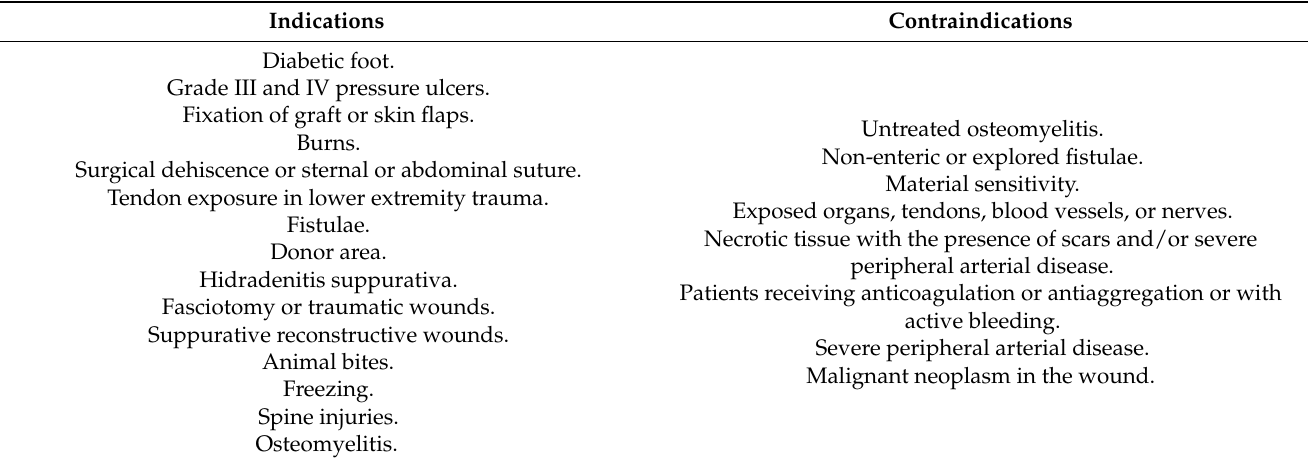
Table 1. Indications and contraindications of